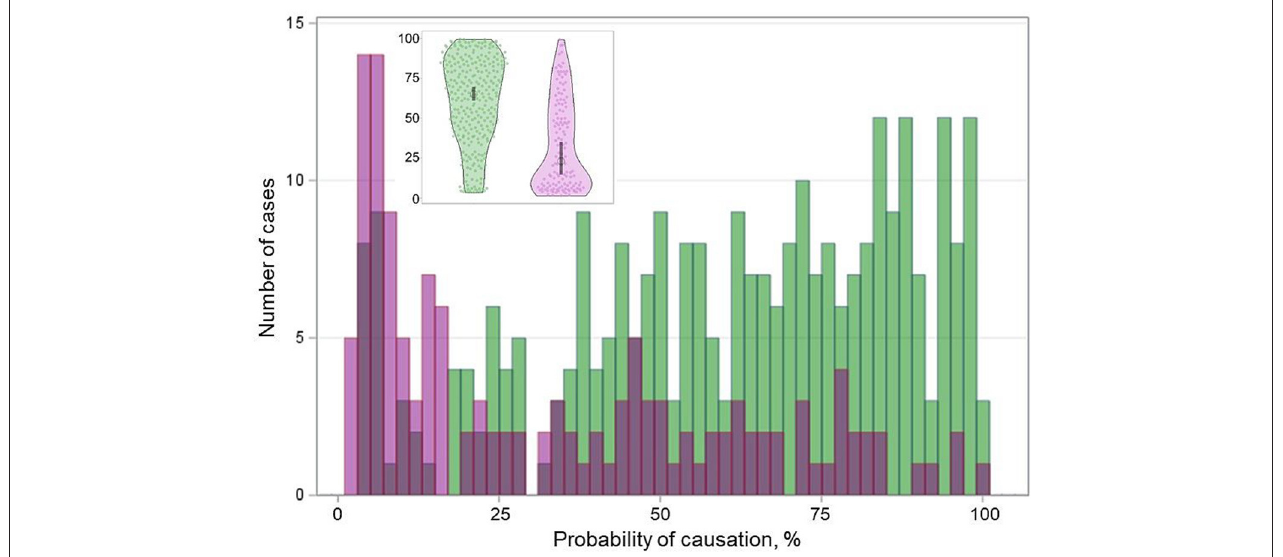
FIGURE 5 | Distribution of the BRAF V600E -positive (purple color) and BRAF V600E -negative (green color) radiogenic PTCs by the probability of causation (POC). Inset is a violin plot of corresponding distribution; the gray boxes indicate the 95% confidence